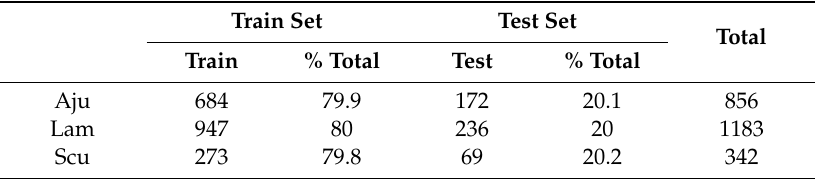
Table 9. Summary of the five di ff erent sets of training and test related to SOM obtained with diterpenes only from Clade IV (Aju, Lam and